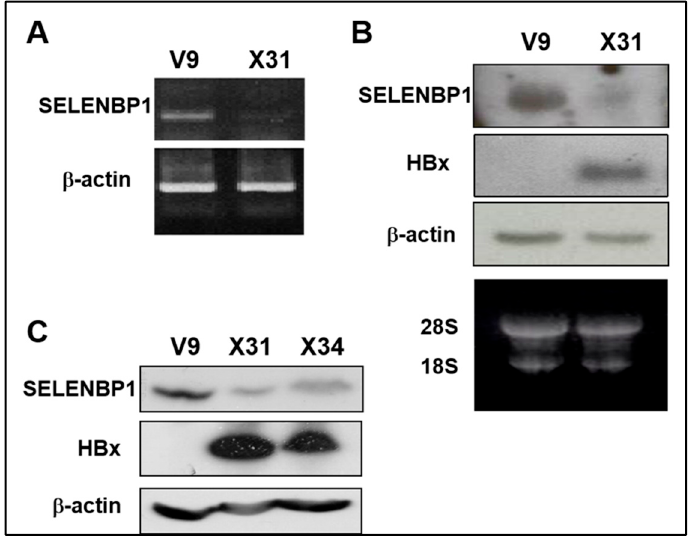
Figure 1. Reduced SELENBP1 expression in HBx -expressing cells. (A) Expression